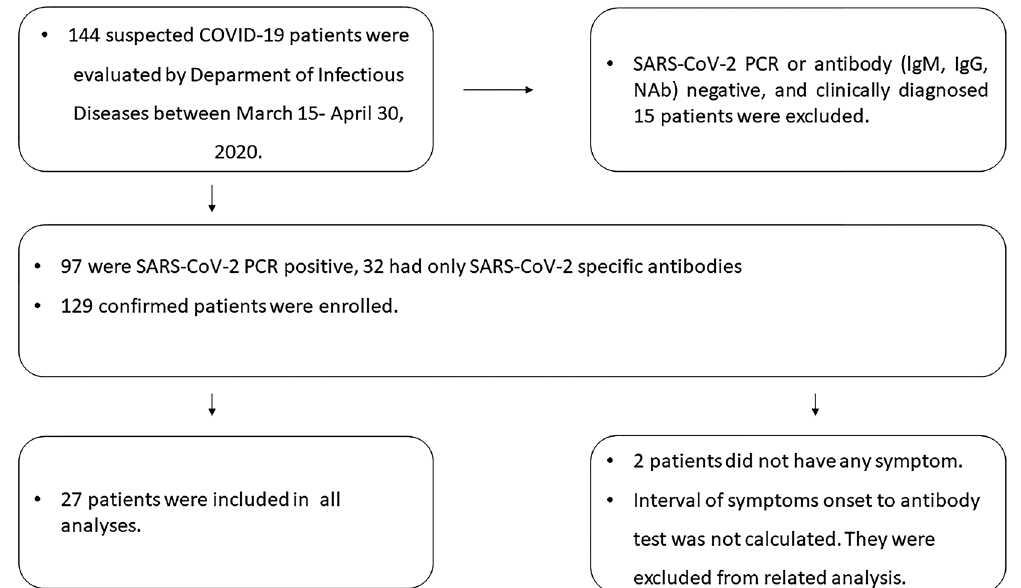
Figure 1: Flowchart of the